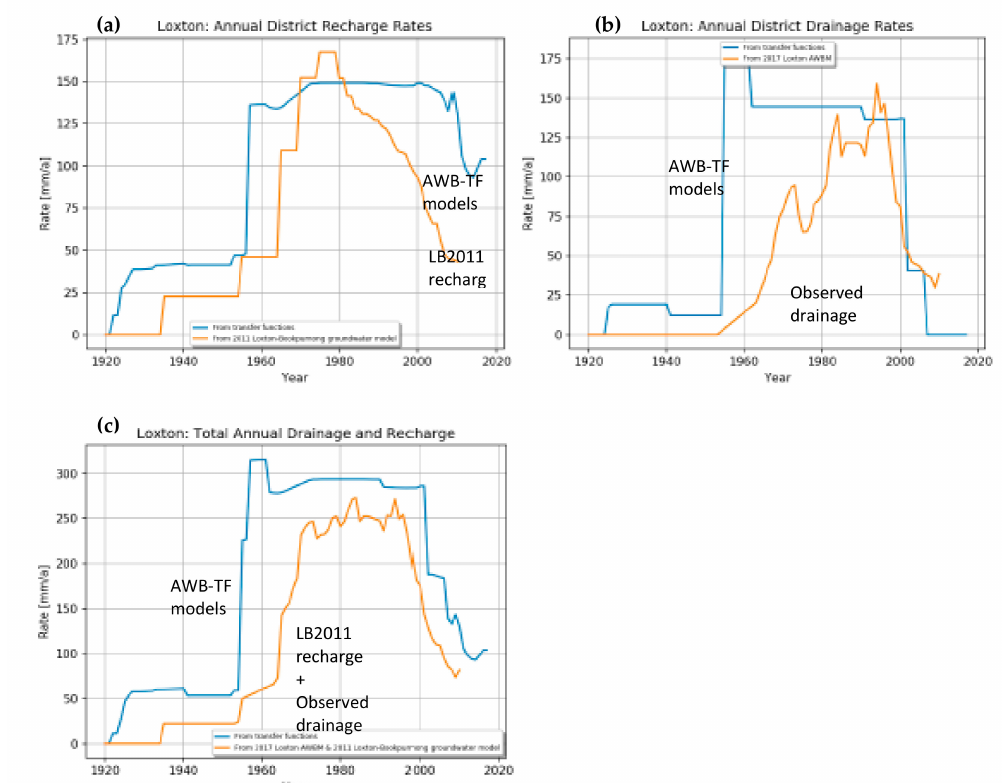
Figure 5. Comparison of recharge and drainage rates derived from existing methods and datasets (plotted in orange) to those derived the new agronomic water balance (AWB)-transfer functions (TF) models (plotted in blue) for the Loxton irrigation area, showing ( a ) techarge rates, ( b ) drainage rates, and ( c ) total drainage and recharge